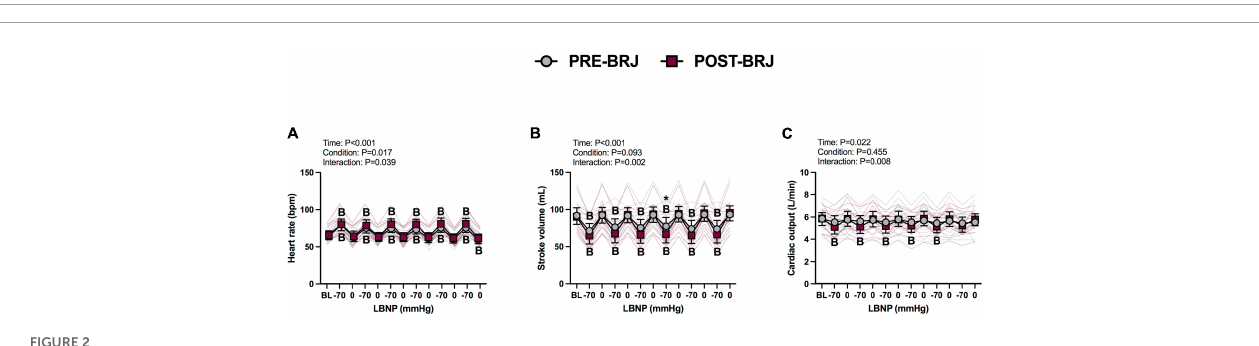
FIGURE2 Individual responses and absolute means with 95% confidence intervals for heart rate (A) , stroke volume (B) , and cardiac output (C) , at the last minute of baseline (BL) and during each 30 s interval of oscillatory lower-body negative pressure (LBNP) before (PRE–BRJ) and 3 h after beetroot